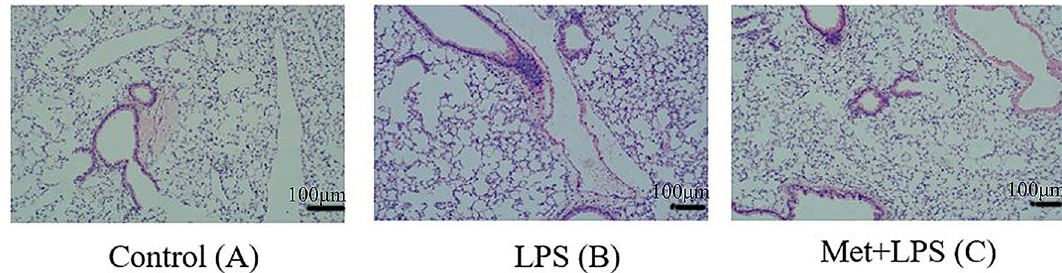
Figure 7. Lung histopathological examination of mice treated with lipopolysaccharide and metformin. ( A ) Normal control mice (× 100). ( B ) Septic mice (20 mg/kg of LPS for 24 h, × 100). ( C ) Septic mice with metformin (× 100). Metformin (250 mg/kg, dissolved in normal saline) was administered intraperitoneally at 1 h before LPS